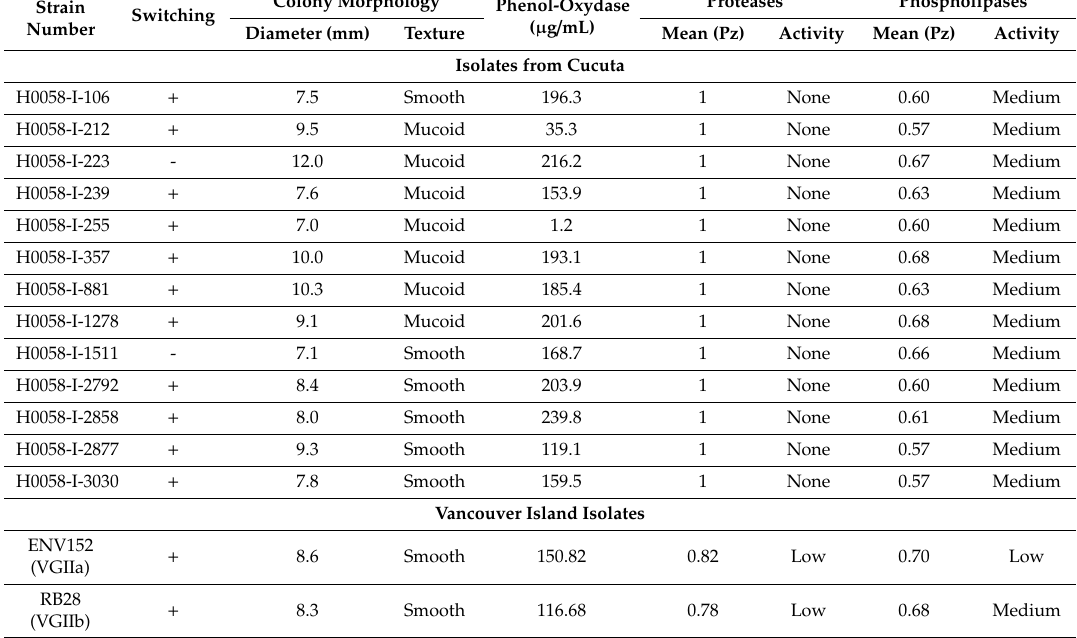
Table 3. Phenotypic characteristics of the studied Cryptococcus gattii VGII isolates growth at 37 ◦